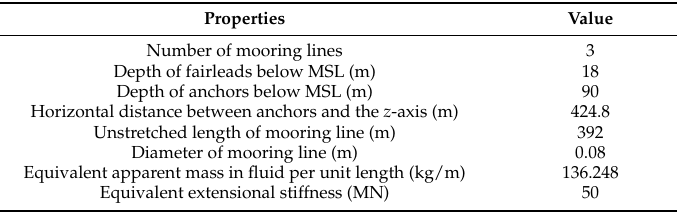
Table 2. Properties of the catenary mooring system.